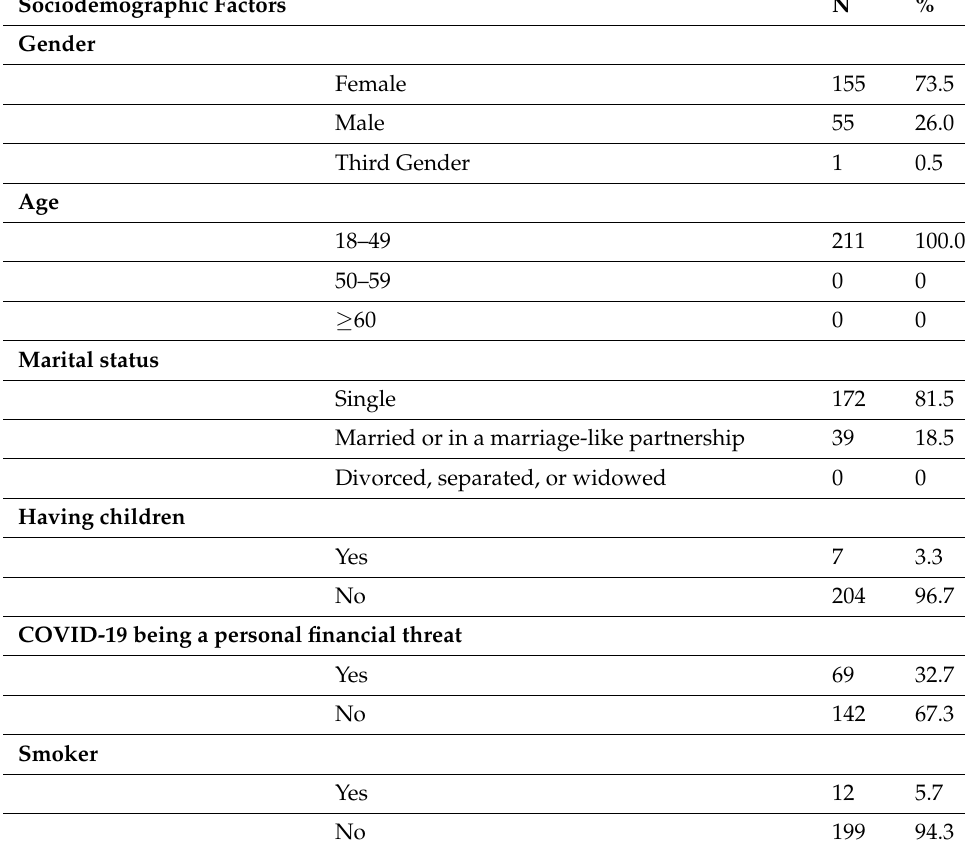
Table 1. Characteristics of participants ( n =